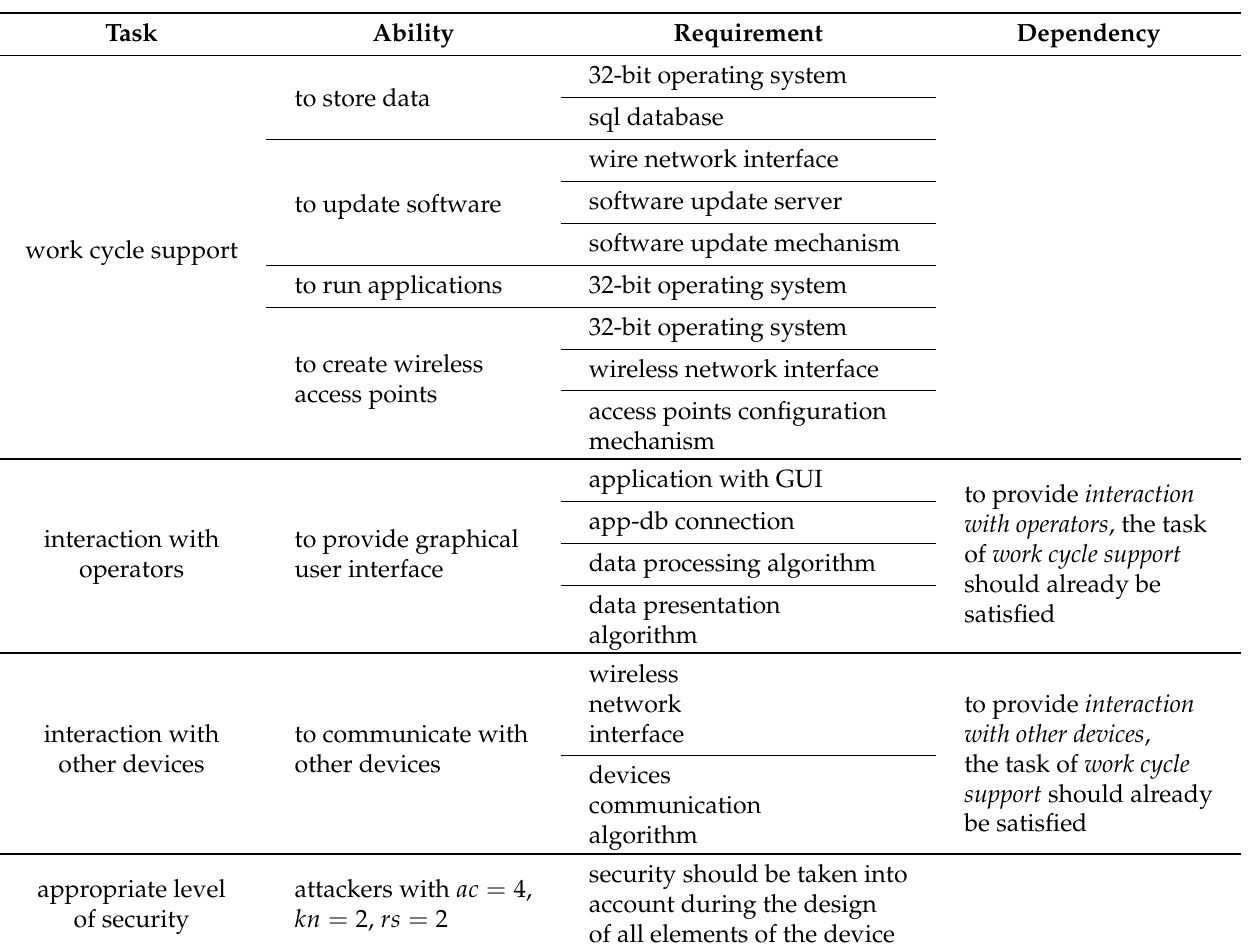
Table 9. Tasks, abilities and requirements related to the